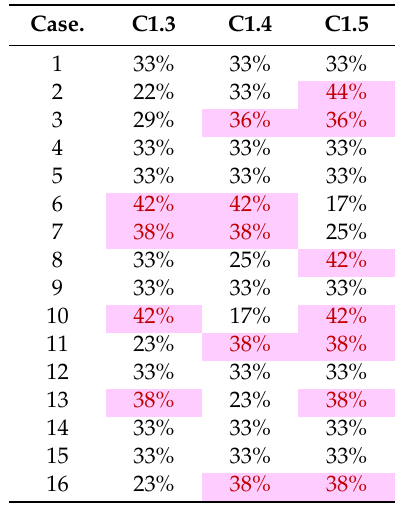
Table 3. Ranking of the relevance of the three factors provided by the prosumers.